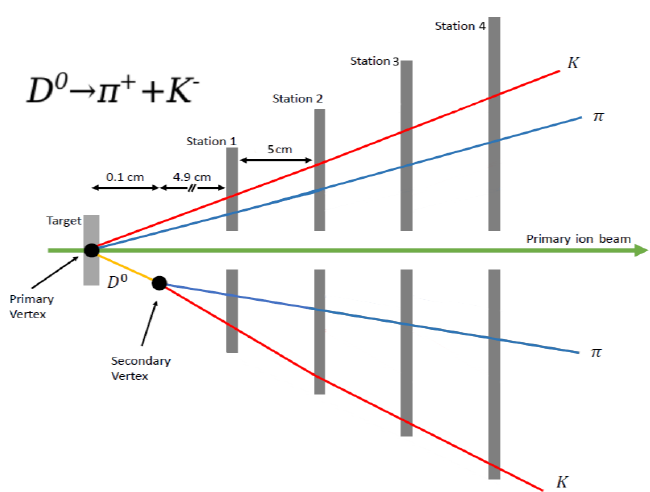
Figure 1. Schematics of reconstruction strategy of D 0 → π + + K − decay channel with help of Vertex Detector. π and K , are produced in primary nucleus-nucleus collisions in large numbers by other sources giving huge background. Note, that the vertices are separated not to